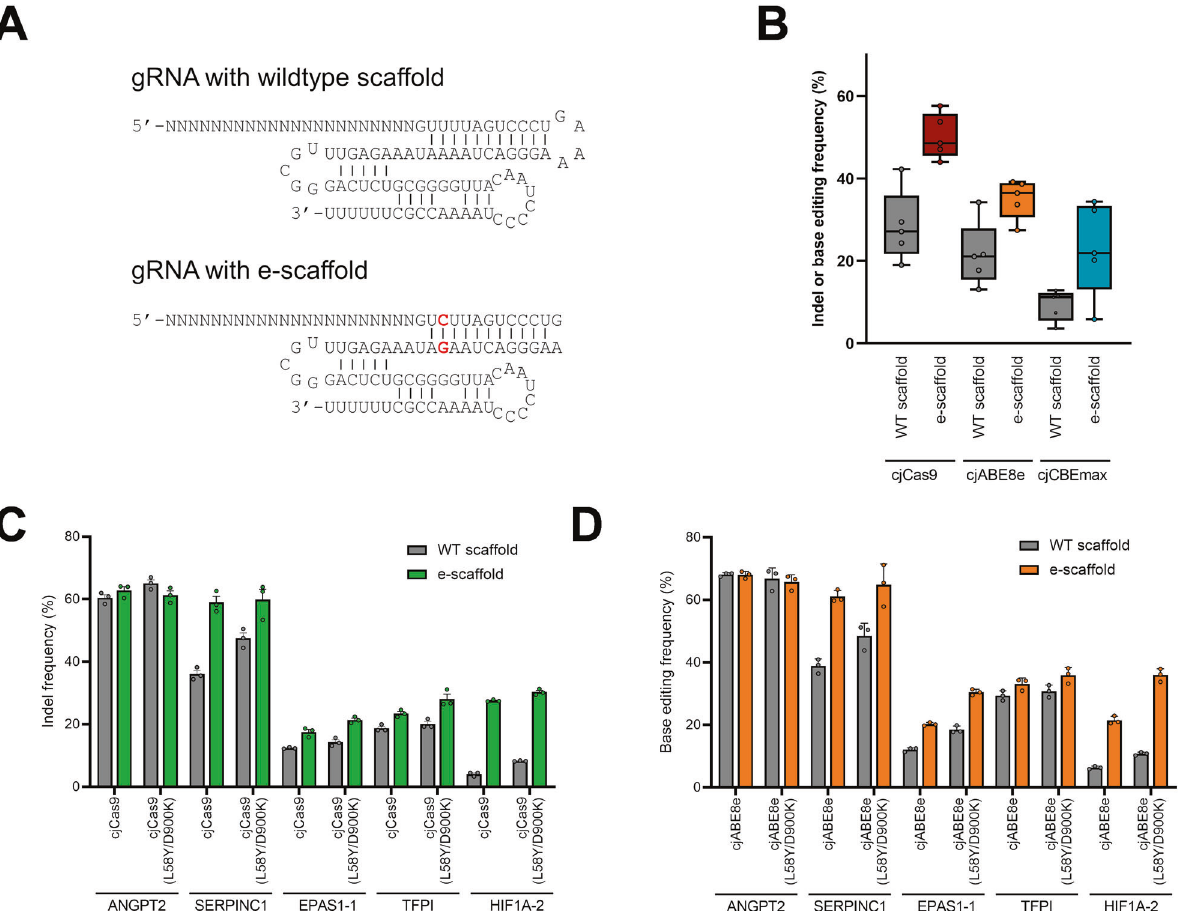
Fig. 3 Engineering of gRNA scaffold and cjCas9 protein for improving base editing ef fi ciency. A The structures of the gRNAs of cjCas9 predicted using the Mfold web server 42 . The e-scaffold was developed by U:A to C:G fl ip in the lower stem and ‘ AA ’ deletion in the tetraloop of the wild-type scaffold. B Mutation frequencies of cjCas9, cjABE, and cjCBE with gRNAs containing wild-type scaffold or e-scaffold sequences at fi ve endogenous target sites. C Indel frequencies of cjCas9 and engineered cjCas9 (cjCas9-L58Y/D900K) with gRNAs containing wild-type scaffold or e-scaffold. D Base editing frequencies of cjABE and engineered cjABE (cjABE-L58Y/D900K) with gRNAs containing wild-type scaffolds or e-scaffolds. All experiments were conducted in biologically independent triplicates. Error bars indicate the standard error of the